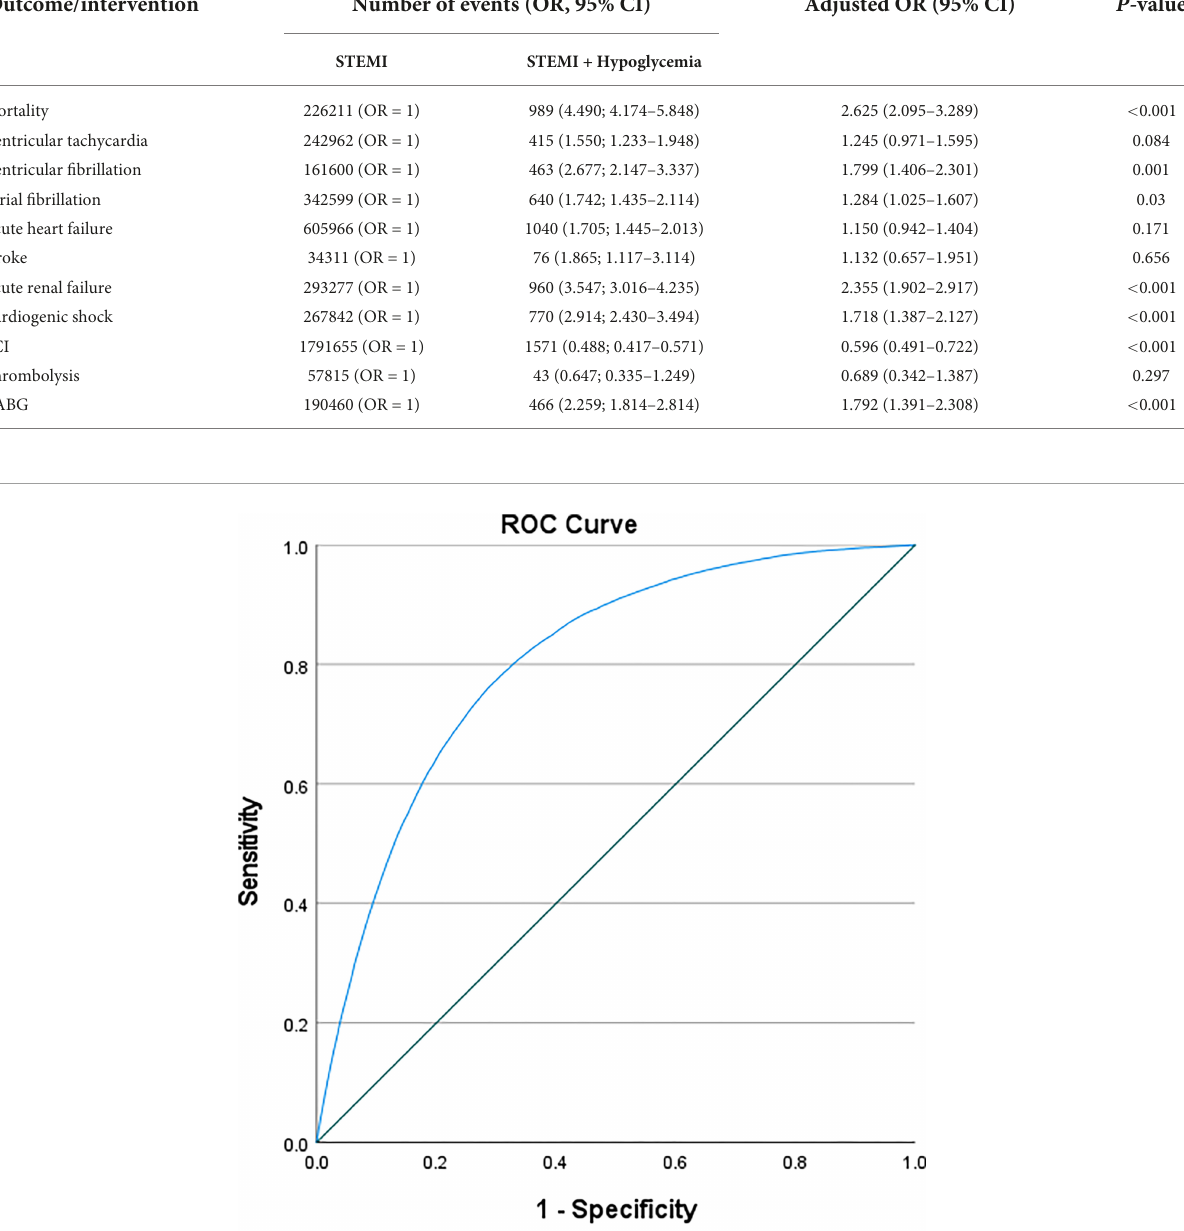
TABLE 3 Cardiovascular outcomes and interventions STEMI patients according to the presence of hypoglycemia. Outcome/intervention